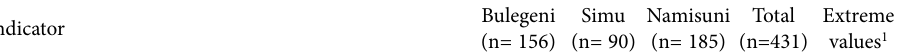
Table 4. Descriptive statistics for the 19 wellbeing